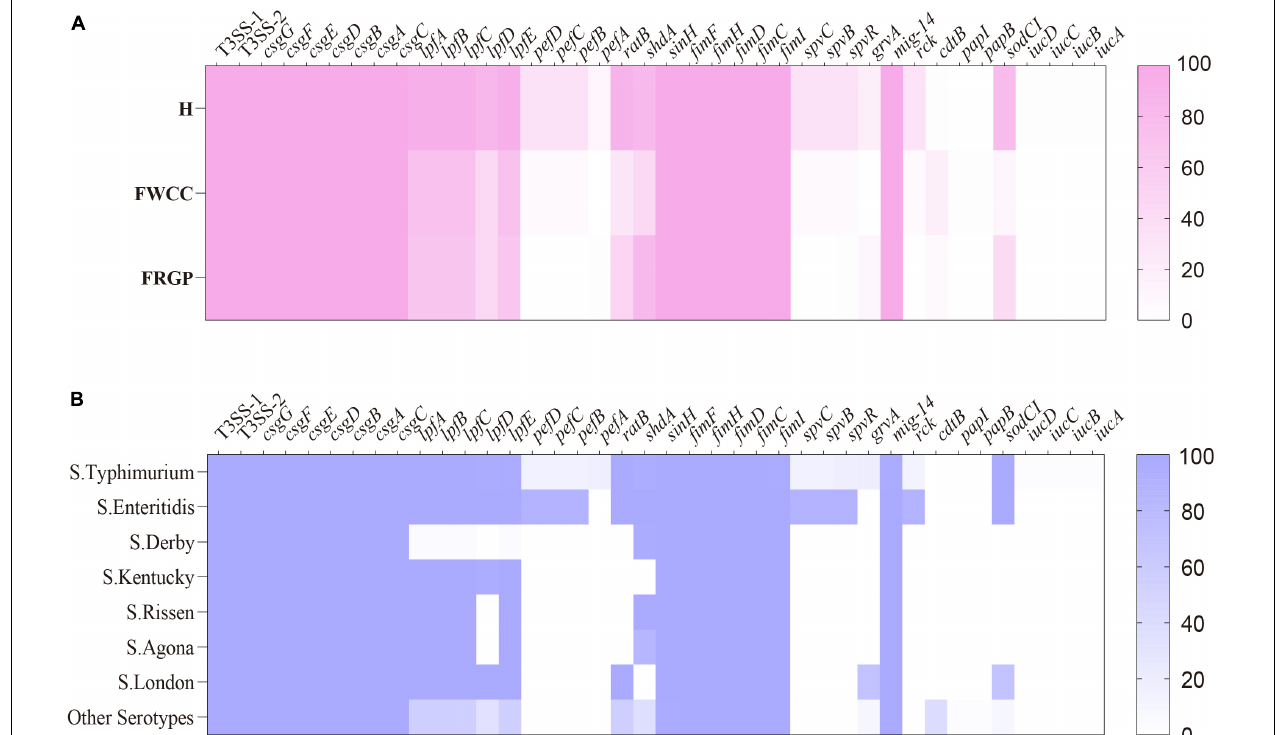
FIGURE 5 | Heatmap of antimicrobial virulence genes according to sampling sources: (A) serotypes; (B) H, human; FWCC, frozen whole chicken carcasses; FGRP, frozen raw ground